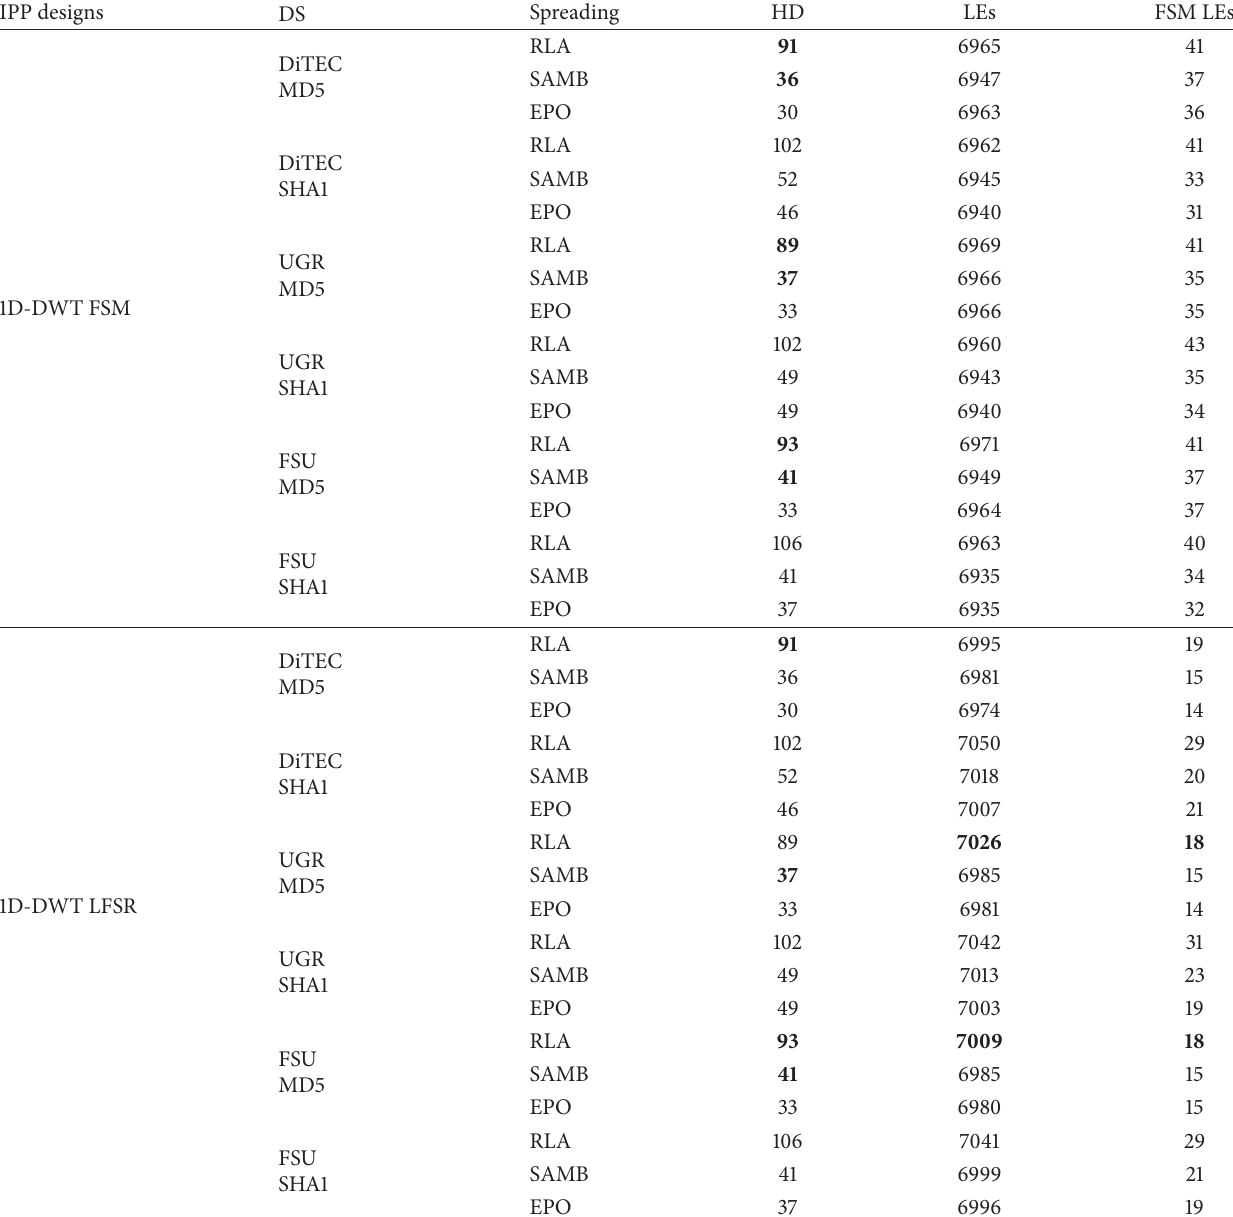
Table 4: Detailed synthesis results for Altera design tools and Apex20kc